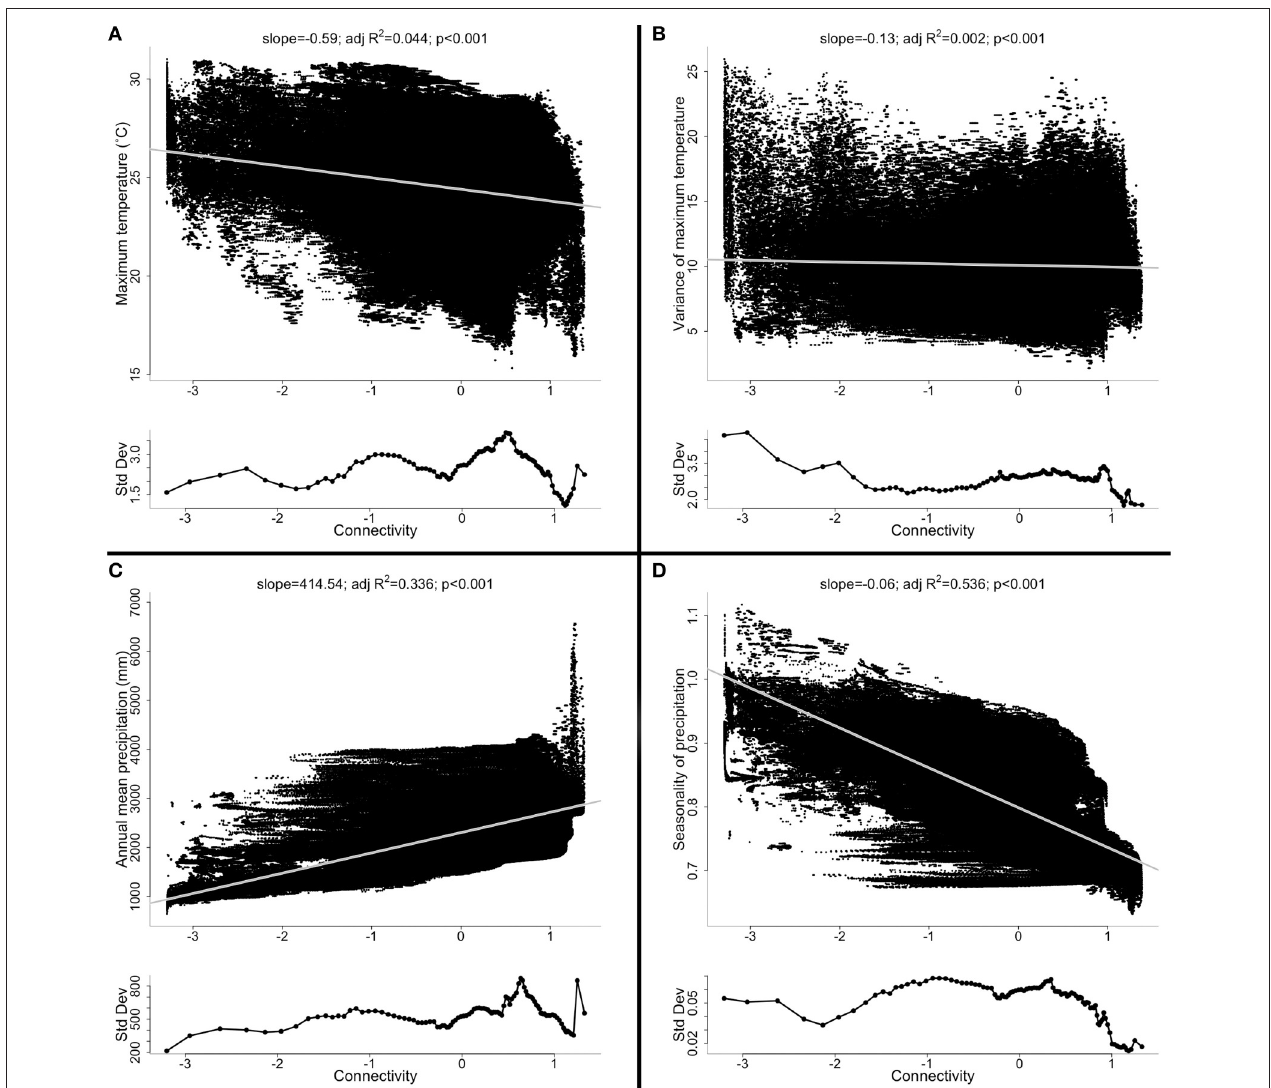
FIGURE 3 | The relationship between connectivity and (A) average maximum daily temperature (Tmax); (B) variance of Tmax; (C) annual mean precipitation; and (D) seasonality of precipitation. Also shown is the relationship between connectivity and the standard deviation of each of the above climatic variables (lower inset panels). In Australia’s Wet Tropics, geographic marginality (defined here by connectivity) is often related systematically to climate. Weakly and strongly connected populations often differ in mean climate. The variation in climate sampled, however, (lower inset panels) is often just as high, or higher, in the weakly connected populations as it is in the strongly connected populations. See Supplementary Information for more